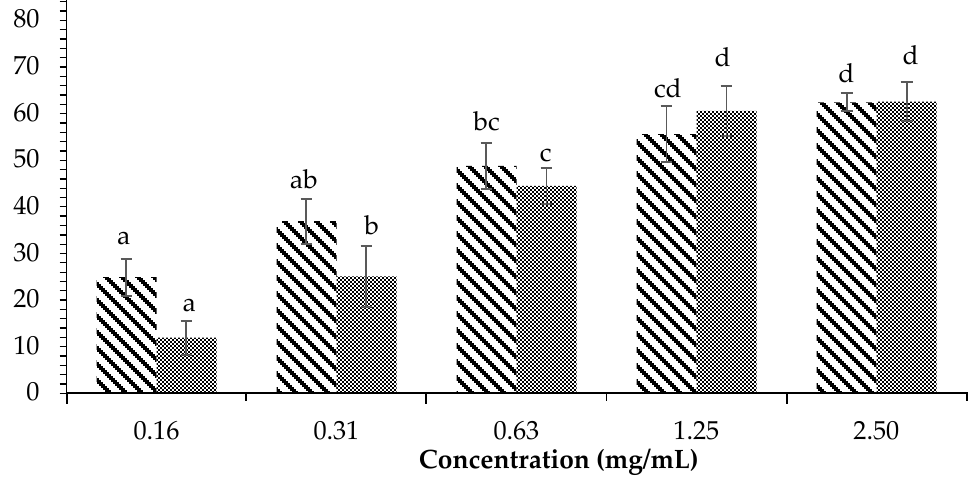
Figure 2. Effects of concentration of ethyl acetate fraction of H. tuna ( ) and acarbose ( ) on α - amylase inhibition. Each value is expressed as mean ± SD in the triplicate experiment. Values (a–d) with different alphabet letters indicate significant differences among treatments at p < 0.05, which was analyzed using Tukey’s HSD.